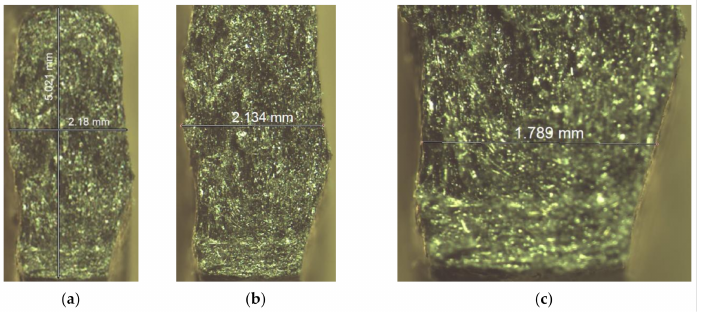
Figure 13. Cross-sectional views of PLA-CF specimens observed after failure using a stereo micro- scope; ( a ) a 1.8 mm thick Scheme × 6 magnification, ( b ) a 1.8 mm thick specimen, × 12 magnification, ( c ) a 1.8 mm thick specimen, × 25